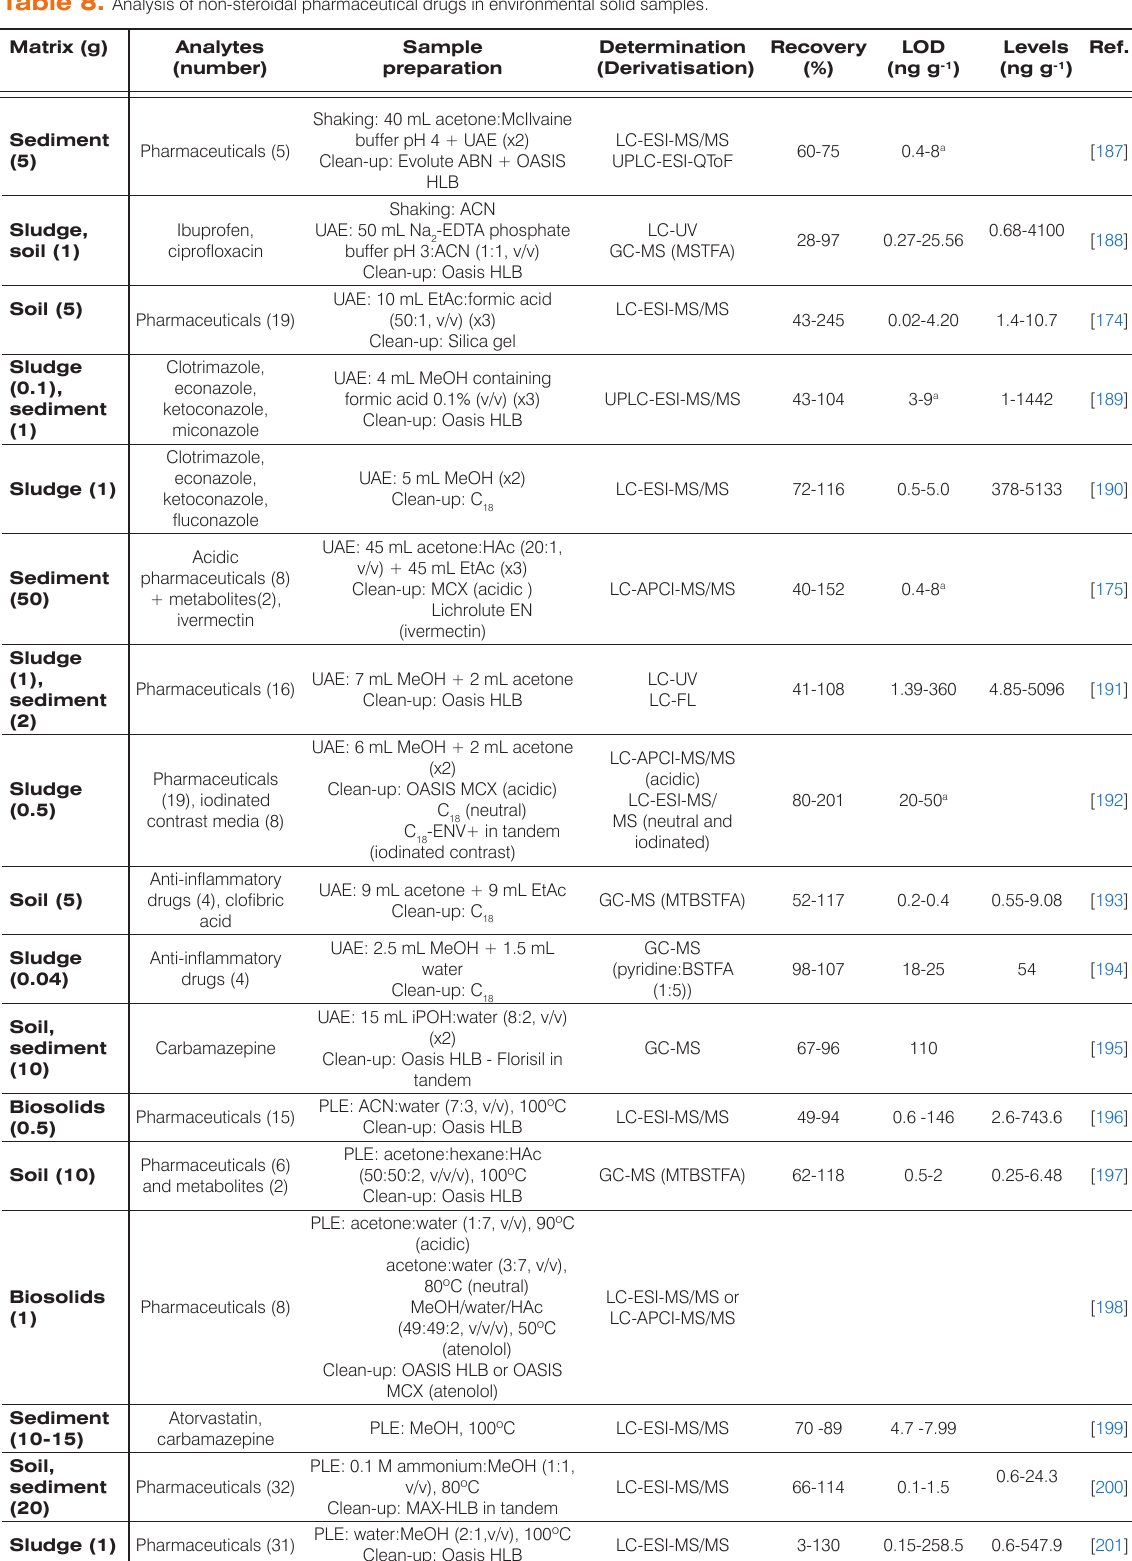
Table 8. Analysis of non-steroidal pharmaceutical drugs in environmental solid